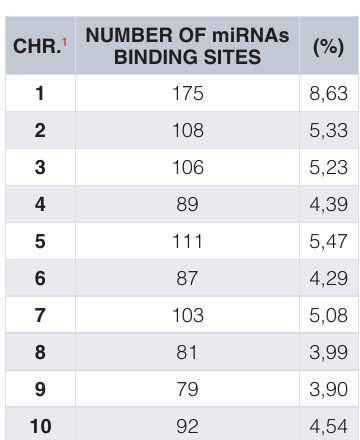
Table 4. Chromosomal distribution of binding sites identified in miRNAs associated with CC.